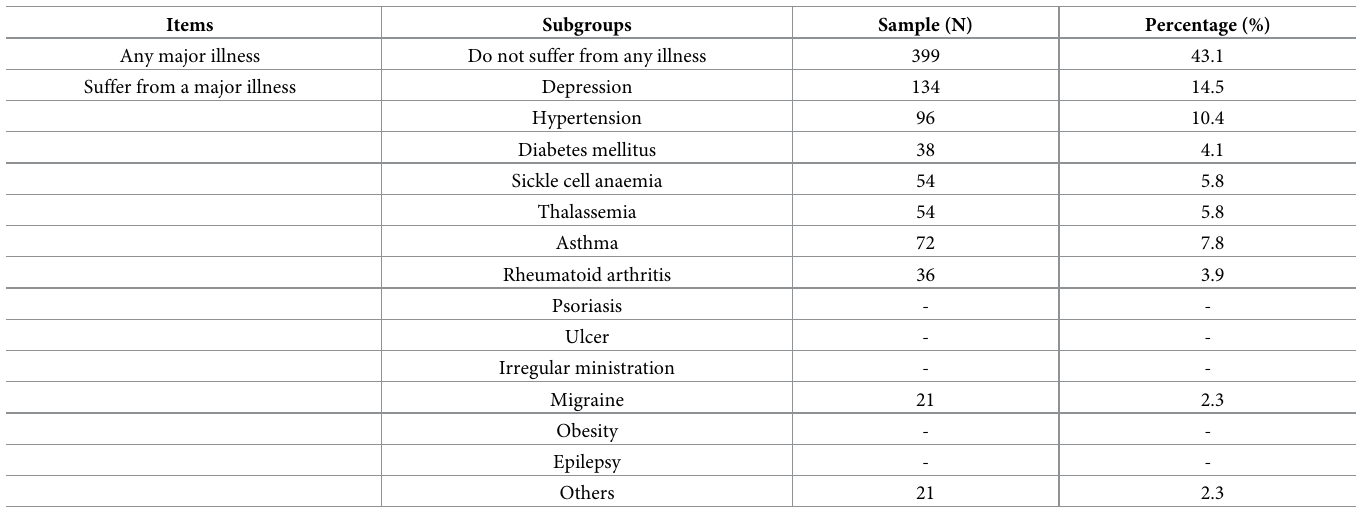
Fig 1. Percentage of participations from various departmental students. Here, BBA: Bachelor of Business Administration, EB: Economics and Banking, CSE: Computer Science and Engineering, EEE: Electrical and Electronics Engineering, ELL: English Language and Literature. https://doi.org/10.1371/journal.pone.0249897.g001 Table 2. Suffering of the respondents from illness (if